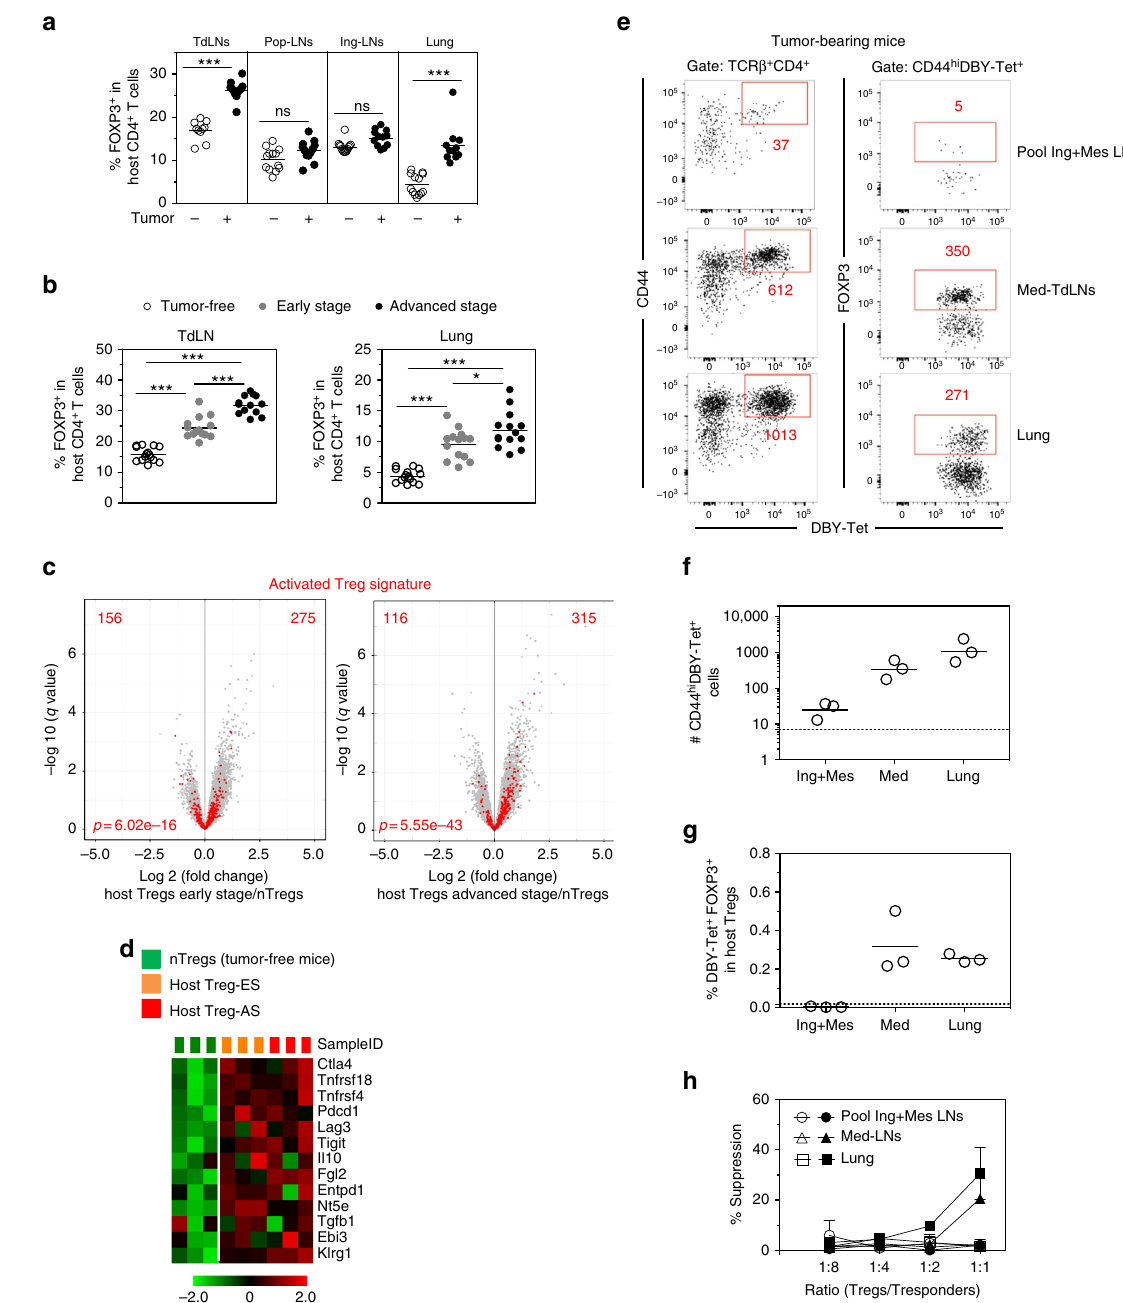
Fig. 7 Host Tregs at the tumor site are enriched in tumor Ag-speci fi c Tregs. a Frequency of host Tregs in the Med-TdLN, tumor non-draining LNs (popliteal = Pop-LNs or inguinal = Ing-LNs) and lung. b Frequency of host Tregs at different stages of tumor growth. ns: non-signi fi cant, * p <0.05, ** p <0.01, *** p <0.001 unpaired t -test. c , d Transcriptional analysis of FACS-puri fi ed host Tregs (CD4 + CD25 hi ) from Med-LNs of tumor-free or tumor-bearing mice. c Volcano plots comparing the q value vs. fold-change for host Tregs from mice bearing ES or AS tumors vs. host nTregs from unmanipulated tumor-free mice. Red dots represent the activated Treg signature. Numbers indicate the upregulated or downregulated genes among the speci fi c signature. The enrichment p value is shown. d Heatmap of genes involved in Treg differentiation and function. e Representative plots of host CD4 + T cells following DBY: I-A b tetramer (Tet)-based cell enrichment of cell suspensions from mice bearing advanced tumors. Total numbers of activated CD44 hi DBY:I-A b -speci fi c host CD4 + T cells (left) and FOXP3 + among DBY:I-A b -speci fi c host CD4 + T cells (right) are shown. f Quanti fi cation of DBY:I-A b -speci fi c host CD4 + T cells. Each point represents a pool of 2 mice. g Frequency of DBY:I-A b -speci fi c FOXP3 + host CD4 + T cells. Dashed lines represent the values obtained in LNs of tumor-free mice. h Suppression assay using puri fi ed host Tregs (FOXP3-GFP pos ) from tumor-free (open symbols) or tumor-bearing mice (closed symbols). Host Tregs sorted from Med-LNs, Ing-Mes-LNs or lungs were cultured for 3 days with CFSE-labeled naive Marilyn cells (Tresponders) and CD3 ε − / − female splenocytes loaded with DBY peptide (2 nM). The graph represents the percent suppression of Marilyn cell proliferation (mean±SEM). One representative experiment out of two is